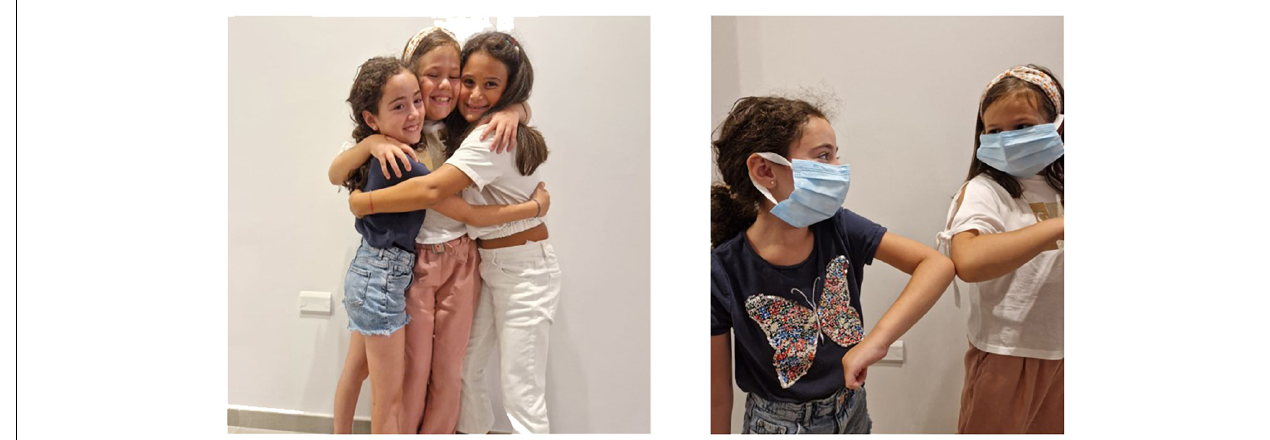
FIGURE 1 | COVID-19